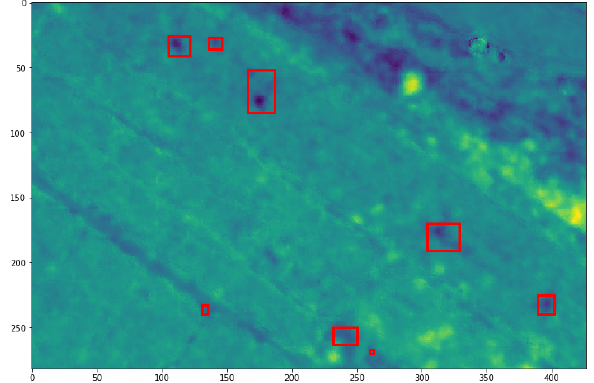
Figure 7. Automatic change detection. Each change zone is labelled with a number and a red box